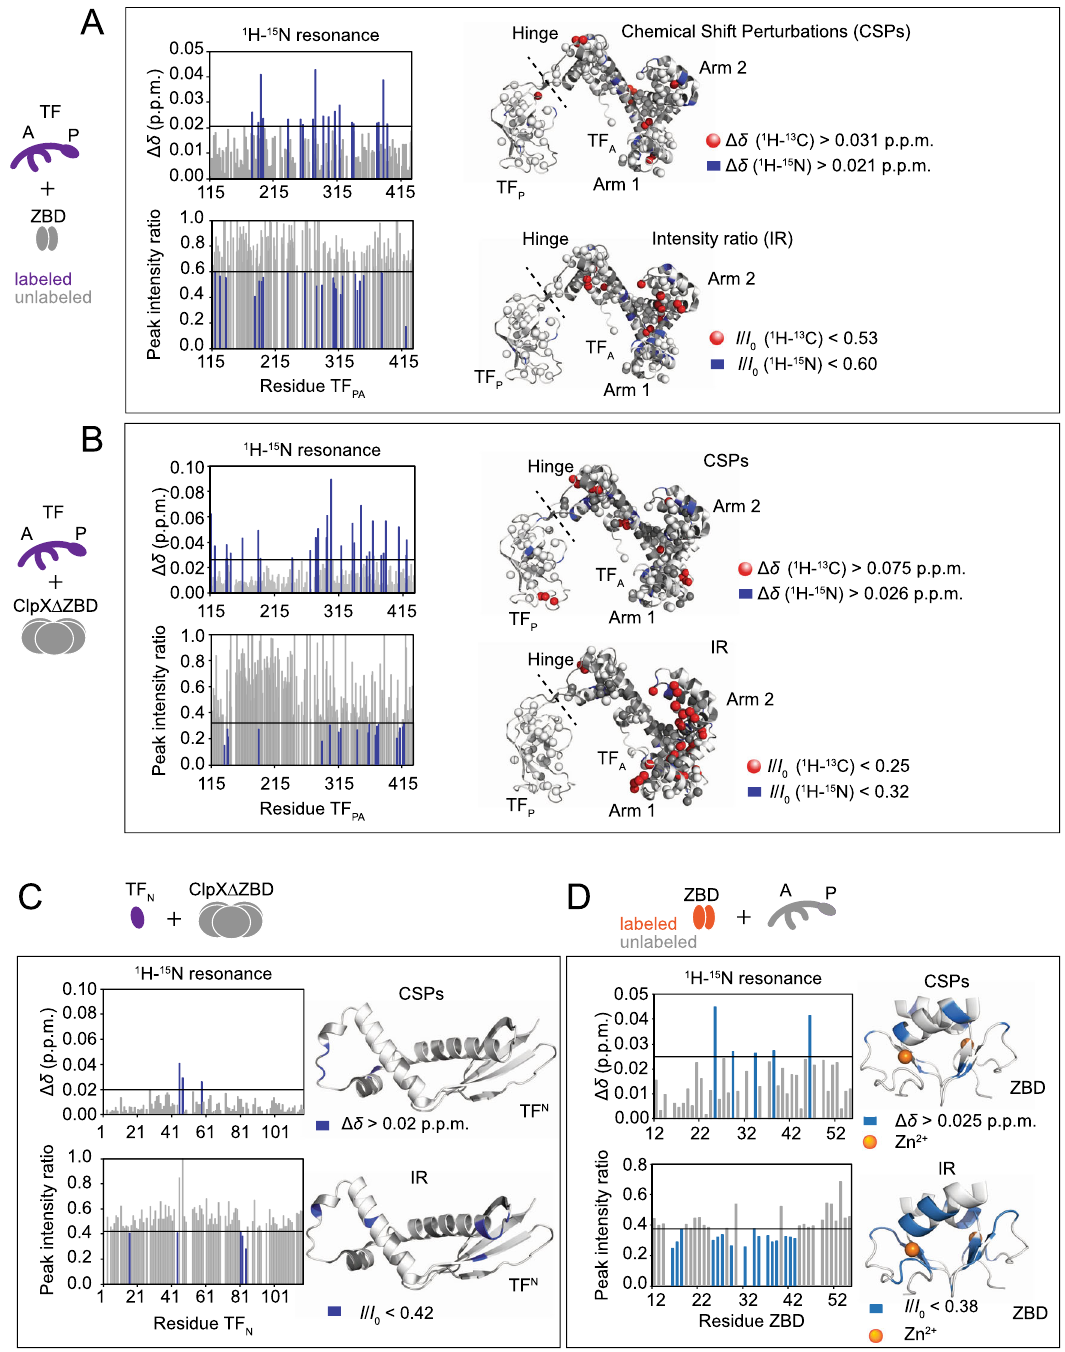
Fig. 4 Mapping the interactions between TF and ClpX using NMR. A – D NMR interaction study for isotopically labeled TF PA and ZBD ( A ) or ClpX Δ ZBD (AAA + domain) ( B ), isotopically labeled TF N and ClpX Δ ZBD ( C ), and isotopically labeled ZBD and TF PA ( D ). Upper left and lower left panels represent the graphs for the chemical shift difference and the peak intensity ratio, respectively, of the backbone 1 H – 15 N resonances. The upper right and lower right panels represent the mapping of the chemical shift perturbations (CPSs) and intensity ratios (IRs) to the crystal structure of TF (PDB: 1W26) 32 or the solution structure of ClpX ZBD dimer (PDB: 1OVX) 71,72 . The dashed line indicates the domain boundary between TF A and TF P . The backbone structure is represented using the ribbon model and the methyl groups of Ile, Leu, Val, Met, and Ala in TF PA are represented as spheres. The methyl groups and backbone of the residues indicating signi fi cant changes are colored red and blue, respectively. The zinc ions in ZBD are represented by orange spheres in panel ( D ). The cutoffs of the chemical shift perturbation mapping were determined by Δ δ ave + Δ δ SD , where Δ δ ave and Δ δ SD are average and standard deviation, respectively, of the chemical shift change upon the addition of the ligand. The cutoff of the intensity change mapping was determined by IR int,ave − IR int,SD , where IR int,ave and IR int,SD are average and standard deviation, respectively, of the intensity